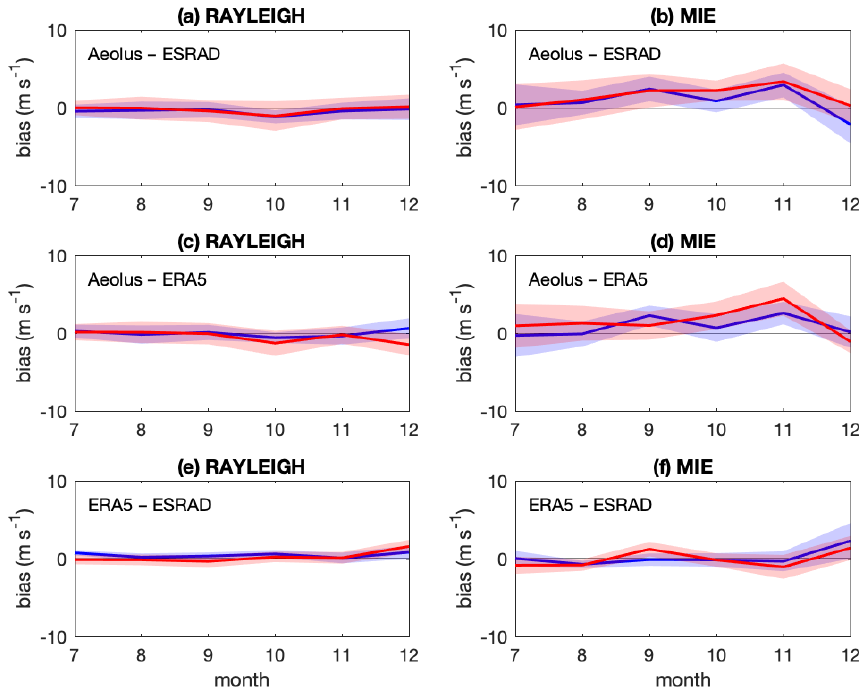
Figure 16. Month-by-month mean values of biases in HLOS winds (solid lines) and 90% confidence limits (shaded areas) at ESRAD. Red is for ascending tracks and blue is for descending ones. (a) Aeolus Rayleigh minus ESRAD, (b) Aeolus Mie minus ESRAD, (c) Aeolus Rayleigh minus ERA5, (d) Aeolus Mie minus ERA5, (e) ESRAD minus ERA5 at available Aeolus Rayleigh comparison times/heights and (f) ESRAD minus ERA5 at available Aeolus Mie comparison